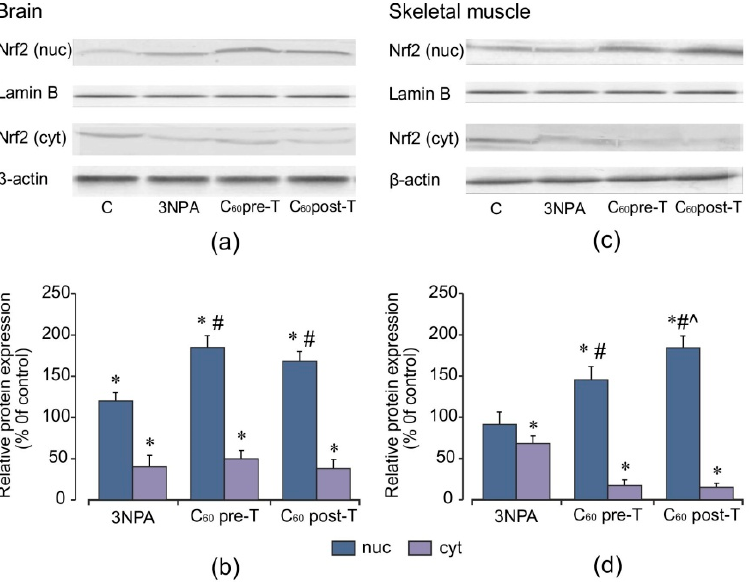
Figure 8. Effect of C 60 and 3-NPA administration on the nuclear and cytosolic Nrf2 protein expressions in the brain and skeletal muscle cells. ( a , c ) Representative Western blot and ( b , d ) densitometric analysis of the Nrf2 protein contents. Protein extracts were separated by performing SDS PAGE and subsequently electroblotted onto PVDF membranes. The values of the nuclear and cytosolic Nrf2 proteins were normalized to Lamin B and β -actin, respectively. Final Western blot figure as the histogram is expressed as mean percentages (± SD) over control values from two independent experiments. The control values are taken as 100%. Statistically significant differences are indicated as * p < 0 05 vs. control; # p < 0 05 vs. 3-NPA treated rats; ^ p < 0.05 vs. C 60 pre-T group.